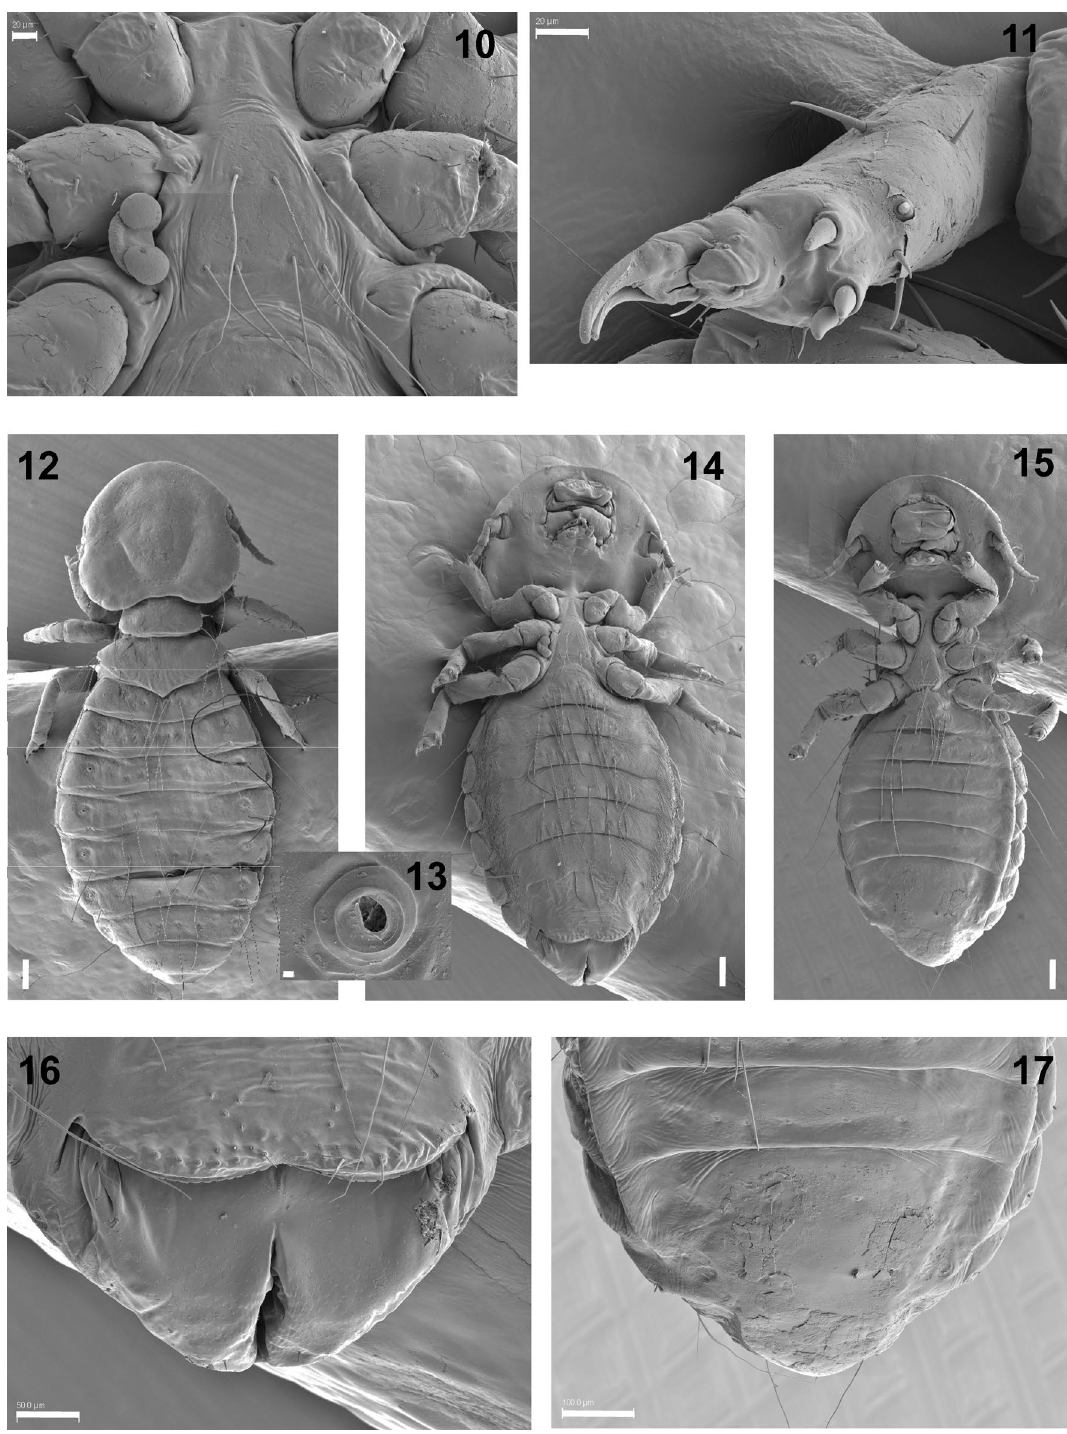
Figure 3. (10) Degeeriella punctifer . Sternal thoracic plate . Scale bar: 20 µm. (11) Degeeriella punctifer . Tarsal claws and tibial processes. Scale bar: 20 µm. (12) Degeeriella punctifer . Dorsal view of an adult female showing the arrangement of the spiracles. Scale bar: 100 µm. (13) Degeeriella punctifer . Detail of a spiracle. Scale bar: 2 µm. (14) Degeeriella punctifer . Ventral view of an adult female. Scale bar: 100 µm. (15) Degeeriella punctifer . Ventral view of an adult male. Scale bar: 100 µm. (16) Degeeriella punctifer . Female. Tip of the abdomen. Scale bar: 50 µm. (17) Degeeriella punctifer . Male. Tip of the abdomen. Scale bar: 100